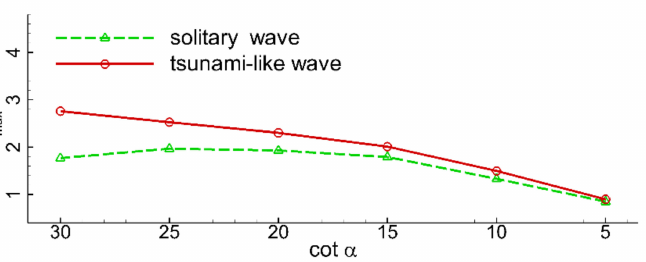
Figure 31. Variations in maximum volume of overtopping water with different beach slopes.